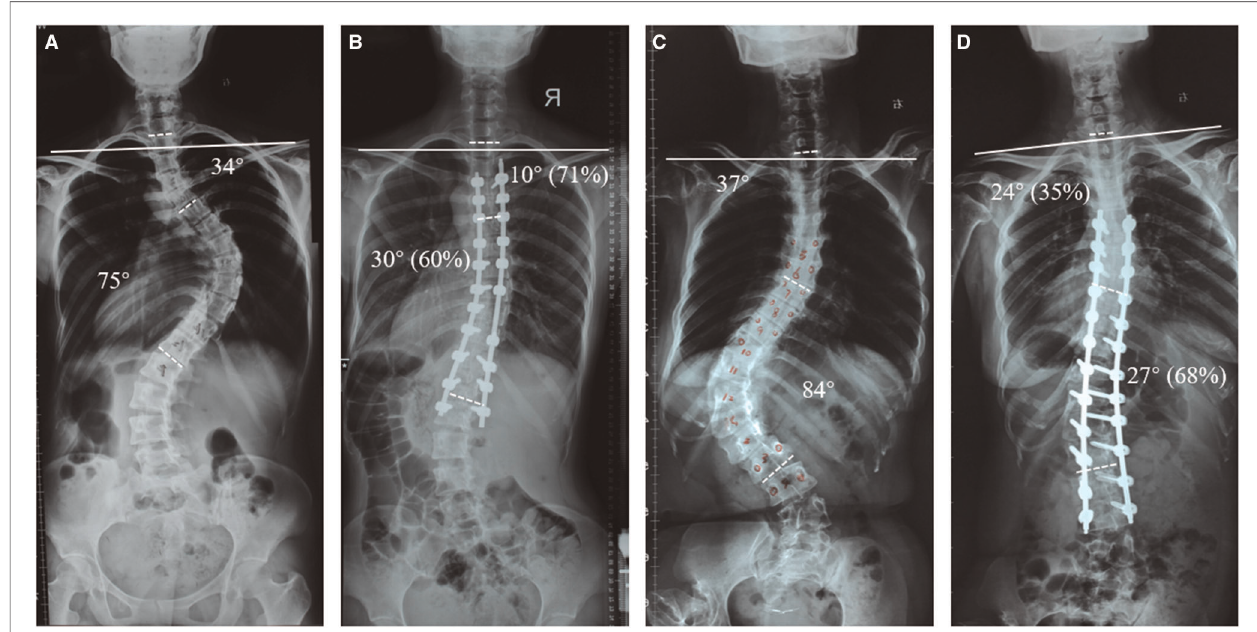
FIGURE 2 | The preoperative ( A ) and postoperative ( B ) images of one patient who underwent relative larger correction of PT curve and lower correction of the MT curve, resulting in postoperative balanced shoulder. The preoperative ( C ) and postoperative ( D ) images of one patient who underwent relative lower correction of PT curve and greater correction of the MT curve, resulting in postoperative imbalanced